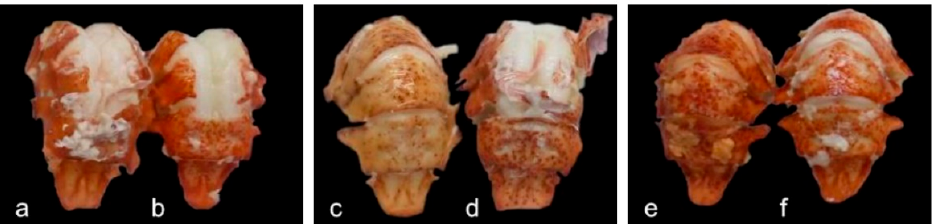
Figure 10. Dorsal view of abdomen muscle after cooking of ( a ) Control during series A; ( b ) Con- trol during series B; ( c ) WAF-CLB during series A; ( d ) WAF-CLB during series B; ( e ) WAF-Diesel during series A; and ( f ) WAF-Diesel during series B.